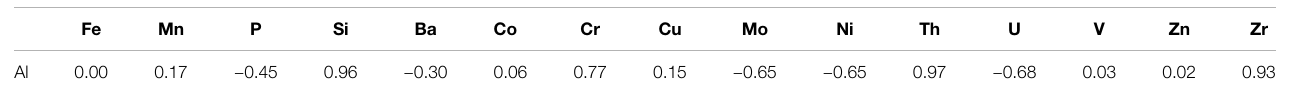
TABLE 1 | Correlation factor r between Al and major and minor